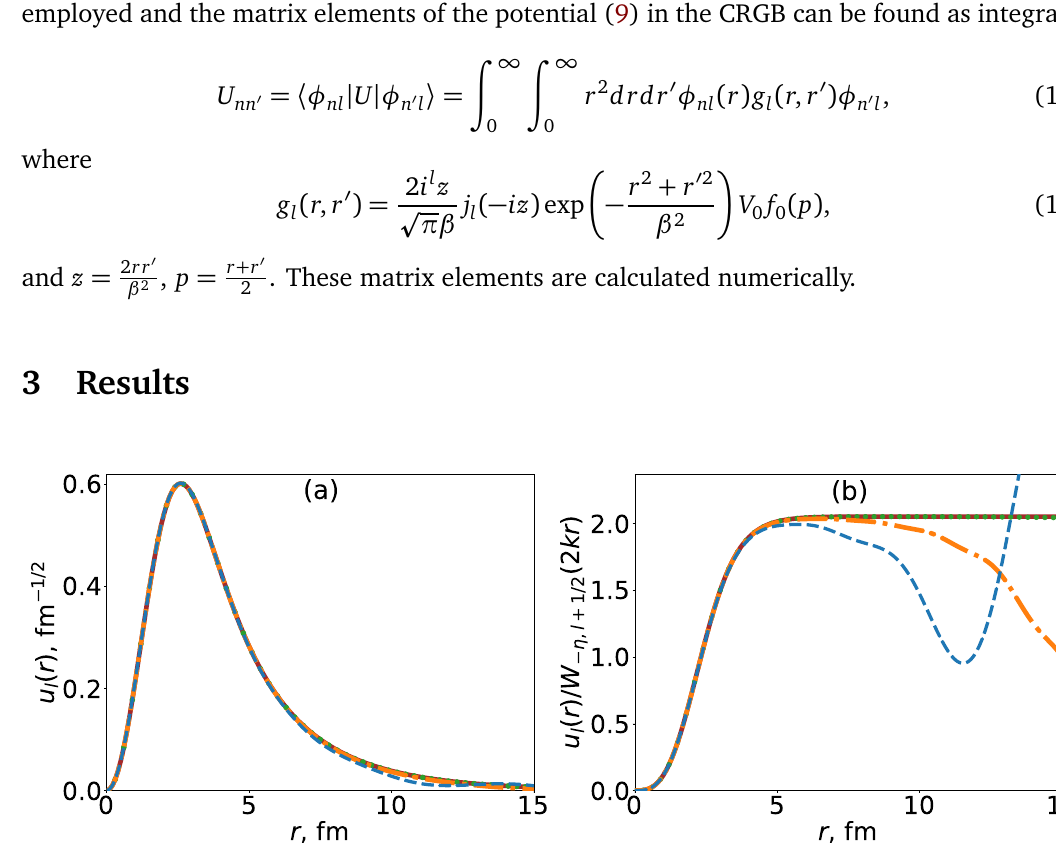
Figure 1: The proton ground state 1 p wave function for p + 12 C (a) and its ratio 1 / 2 to the Whittaker function (b) obtained using CRGB with K = 10 (dashed curves), 20 (dash-dotted curves), 30 (dotted curves), 40 (solid